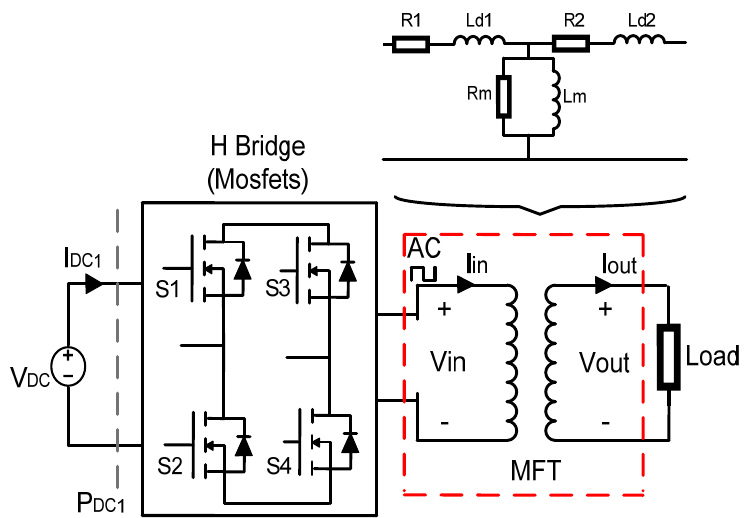
Figure 6. Full-Bridge converter and equivalent MFT circuit. Table 7. Parameters of the simulation model. MFT MFT with Ferrite Core MFT with Nanocrystallyne Core V in 120 V